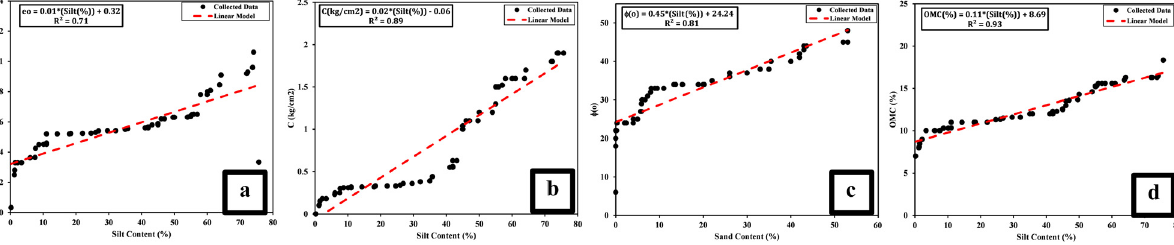
Figure 8: The variation in various soil characteristics vs silt content for Kirkuk city: ( a ) e o vs silt content ( % ) , ( b ) c ( kg/cm 2 ) vs silt content ( % ) , ( c ) ϕ vs silt content ( % ) , and ( d ) OMC ( % ) vs silt content ( % ) .